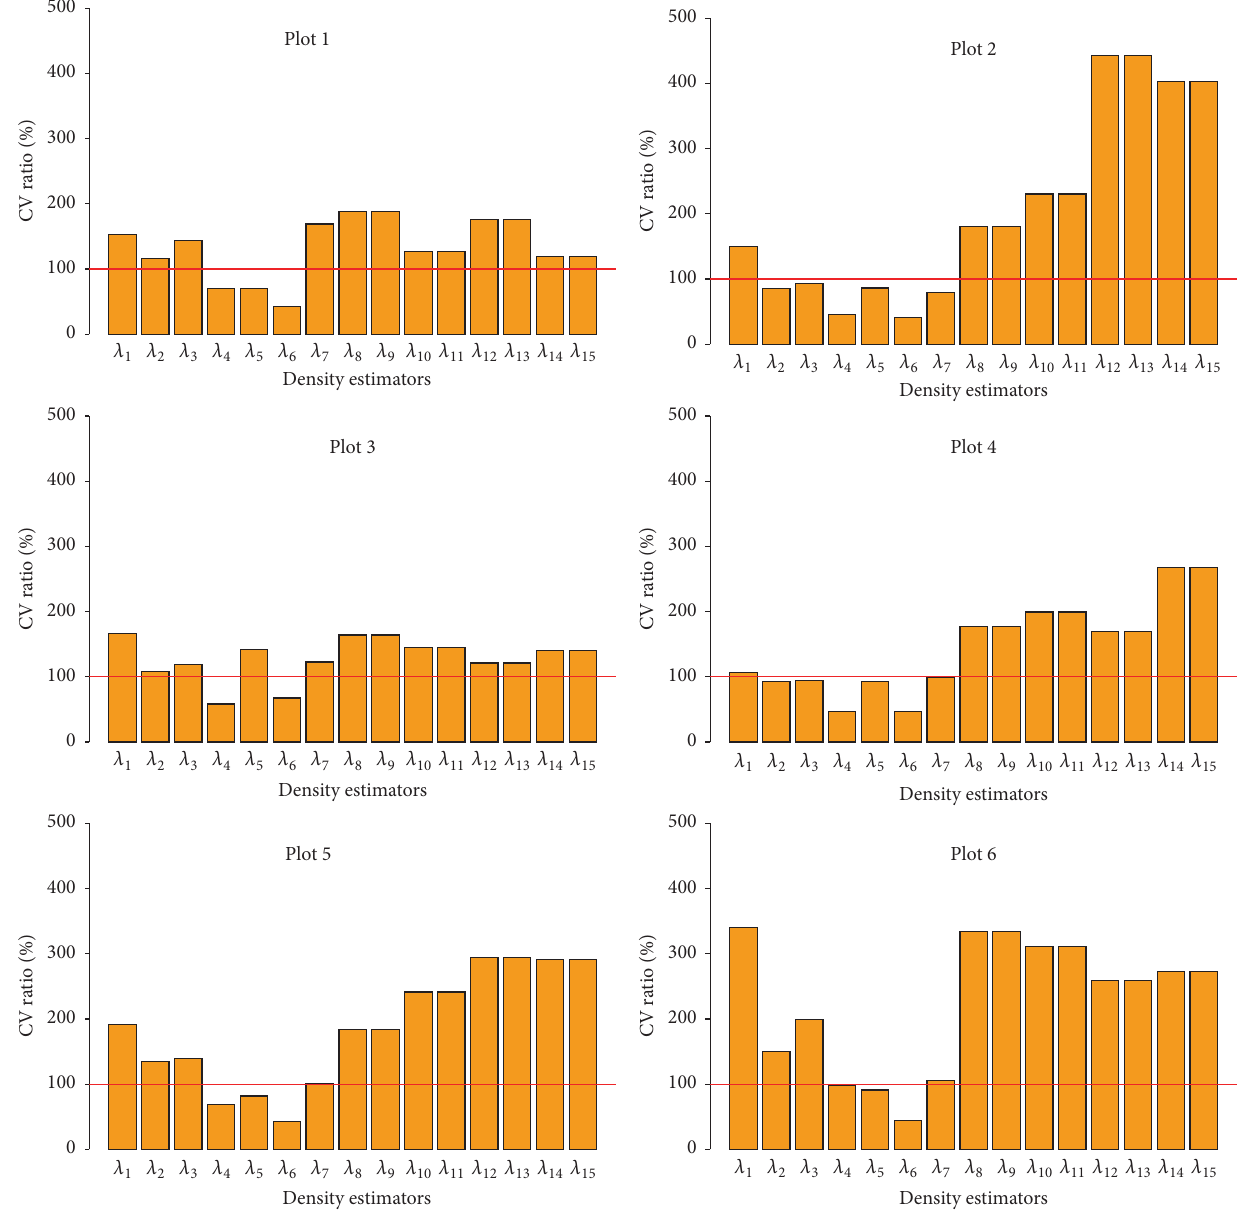
Figure 7: Comparison of the precision obtained when using distance methods or quadrat counts to estimate tree density. The bars represent the ratio between the coefficient of variation (CV) obtained for each estimator and the CV obtained when using quadrat counts. The 100% red line corresponds to the same CV for both the distance estimator and the